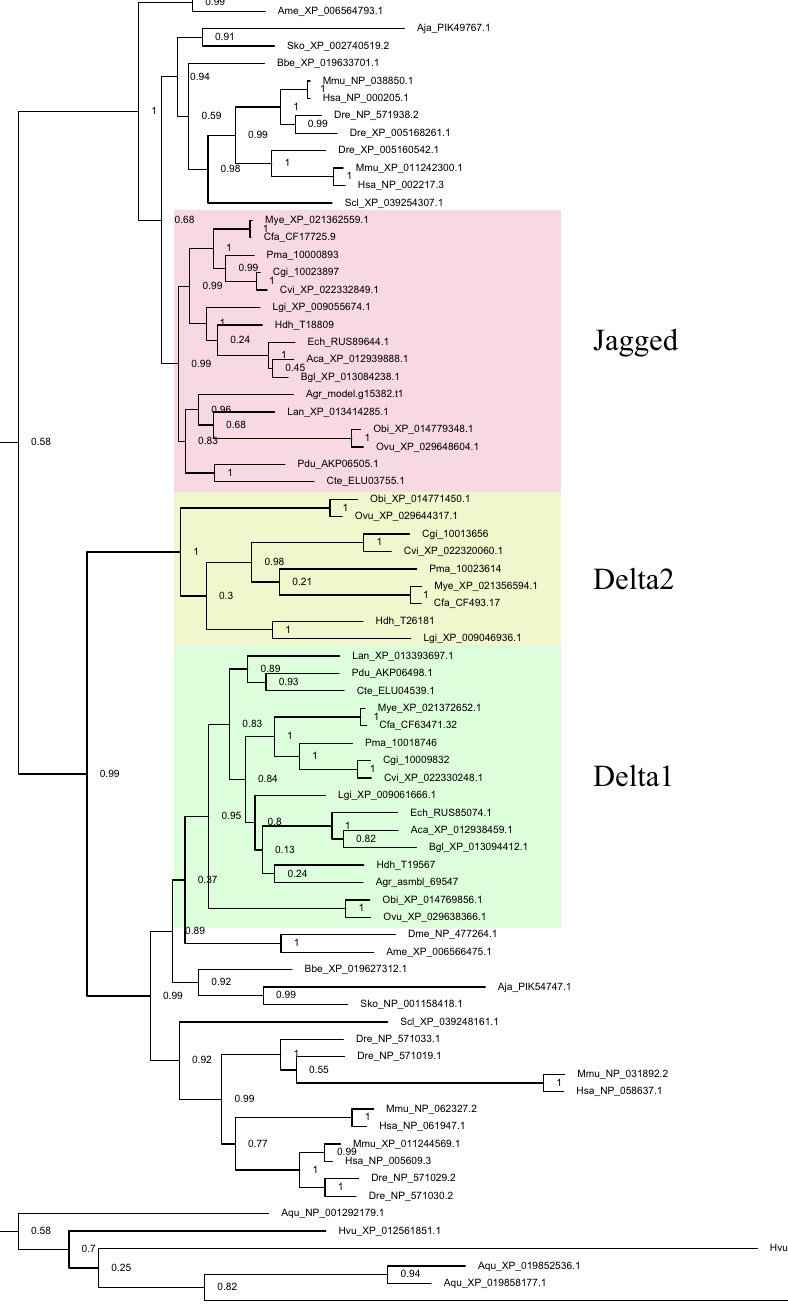
Figure 2. Phylogeny of Notch ligands. Phylogenetic tree of Delta and Jagged genes in metazoans, as determined using the maximum likelihood method. The tree was constructed using 76 ligand genes from 27 complete metazoan genomes (including 16 lophotrochozoans; Platyhelminthes was not included owing to their specific parasitic lifestyle). Green indicates Delta1 in Lophotrochozoans. Yellow indicates Delta2. Pink indicates Jagged ( Serrate in D. melanogaster ) in Lophotrochozoans. Fasttree support values are shown at the basal node. Sequence IDs are shown in Supplementary Table S2. The Delta protein sequences are shown in Supplementary Data